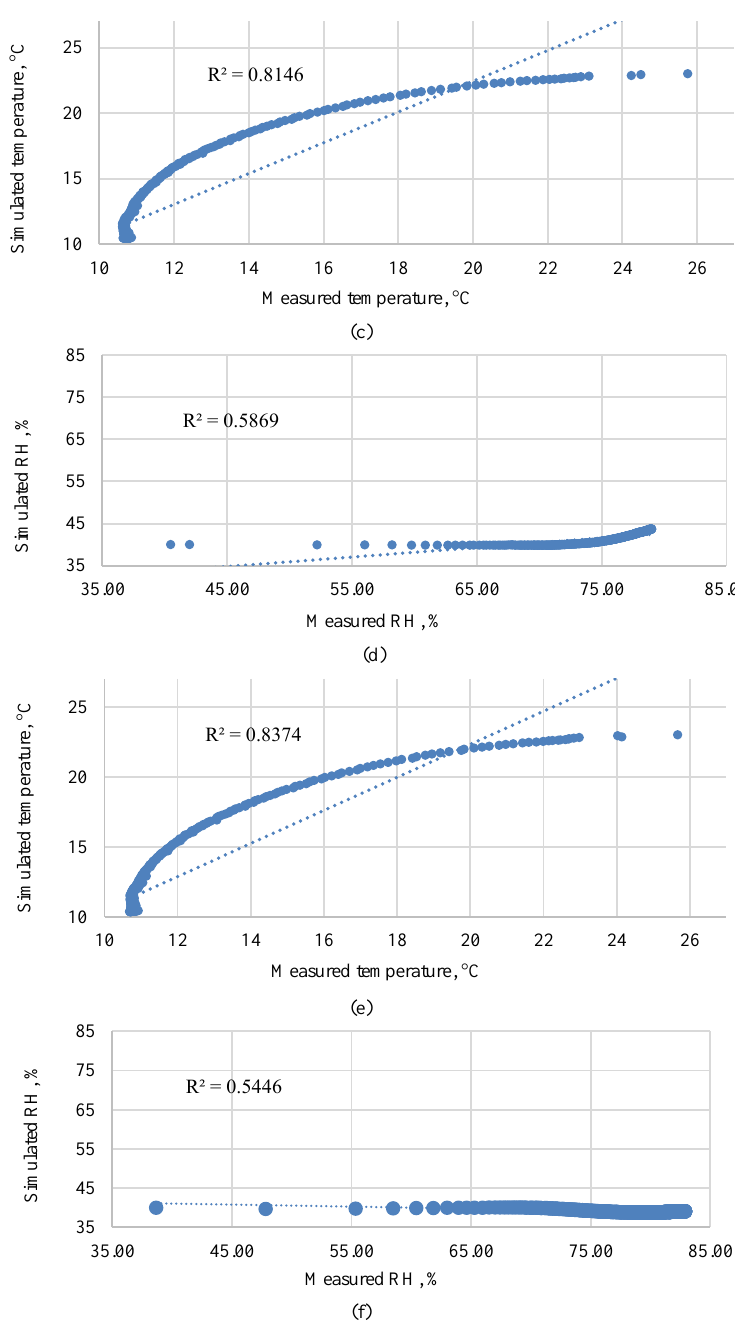
Fig. 8. Correlation between simulated and measured temperatures: a) wood fiber, c) EPS, e) mineral wool. Relative humidity: b) wood fiber, d) EPS, f) mineral wool (between masonry and insulation